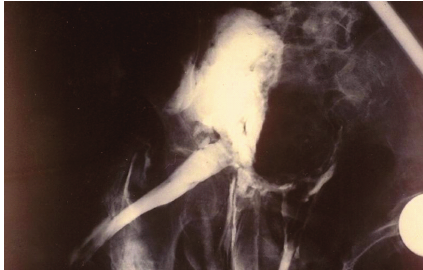
Figure 4: Plain anteroposterior radiograph showing the pelvis 7 minutes after per rectum administration of gastrografin. Gastro- grafin is escaping from the pelvic cavity through a fistula to the